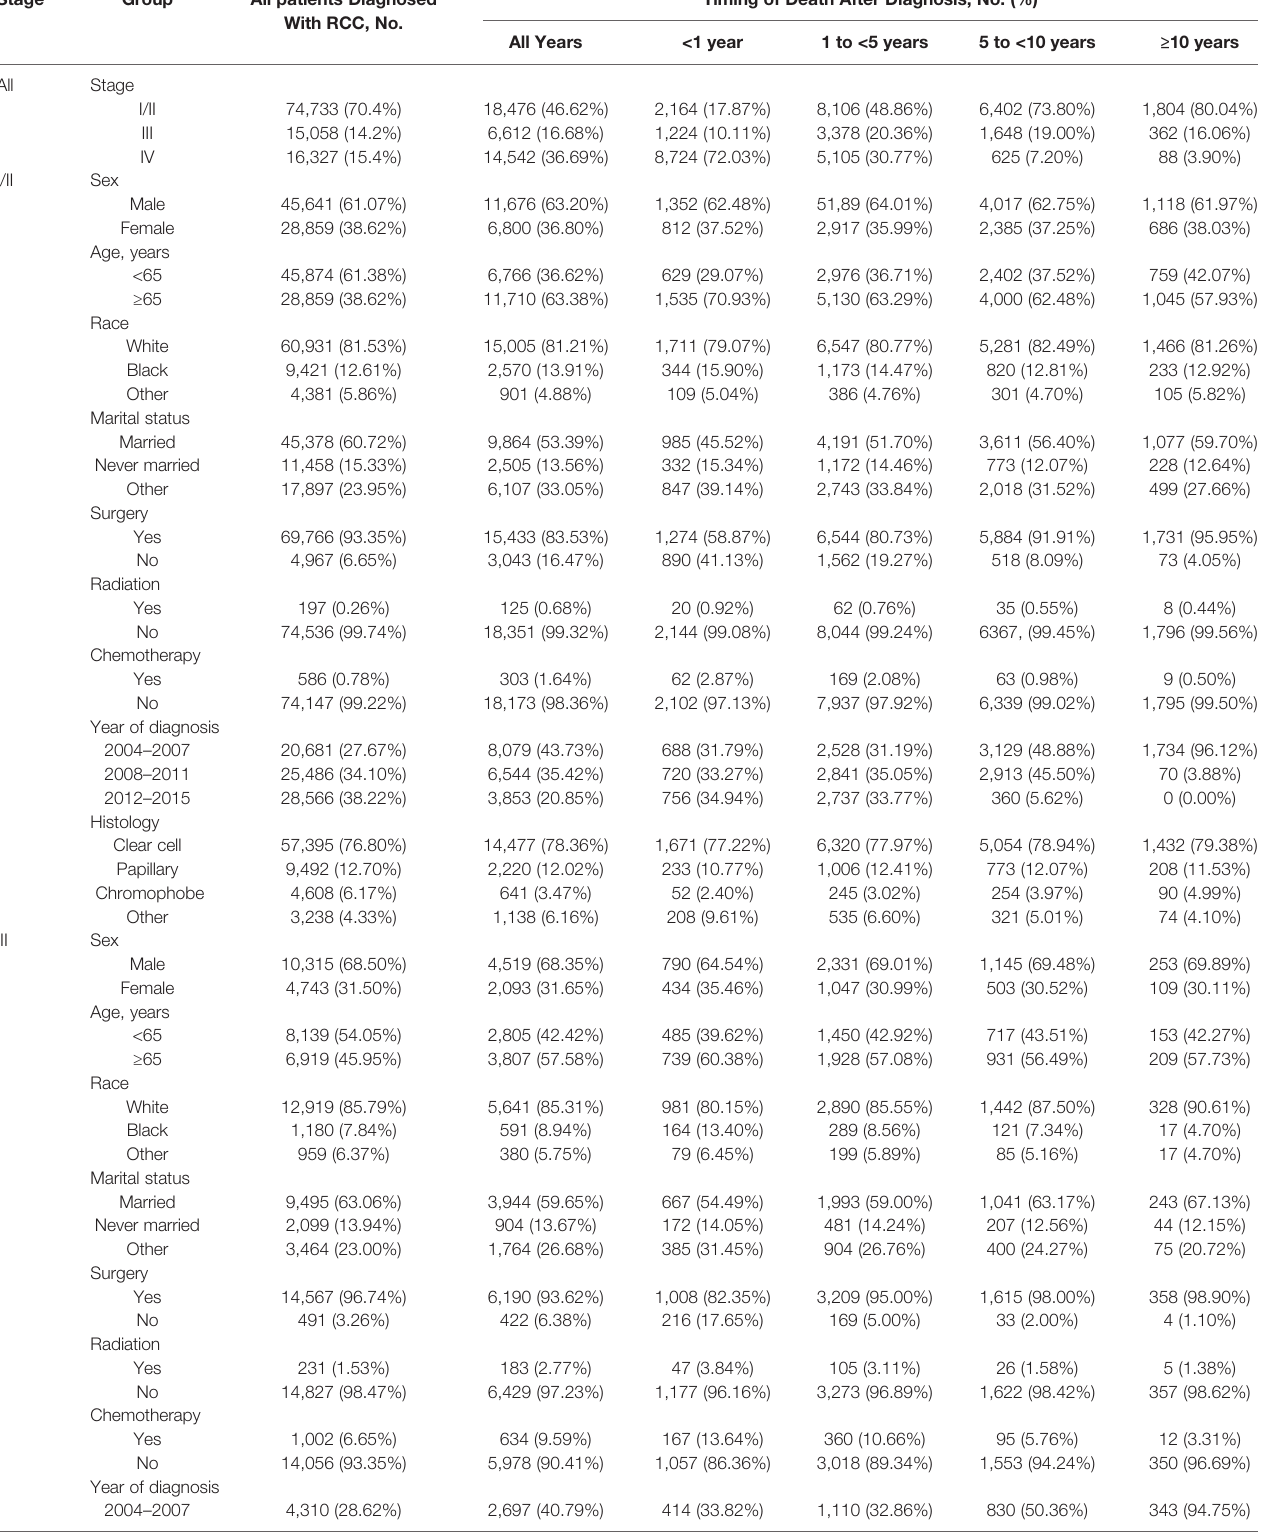
TABLE 1 | Patient characteristics and death by time after